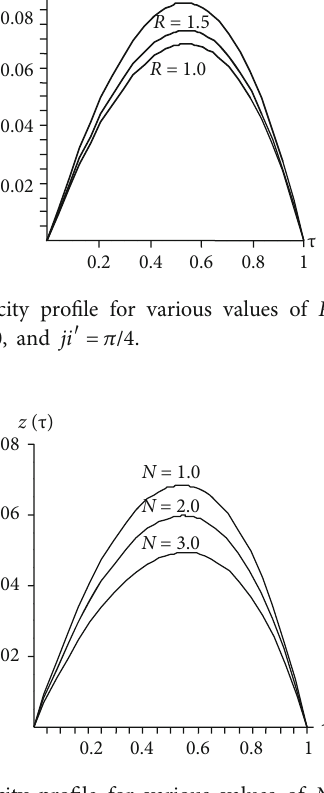
Figure 3: Velocity pro fi le for various values of N with q = 1 : 0 , R = 1 : 0 , A = 1 : 0 , and ji ′ = π /4 .